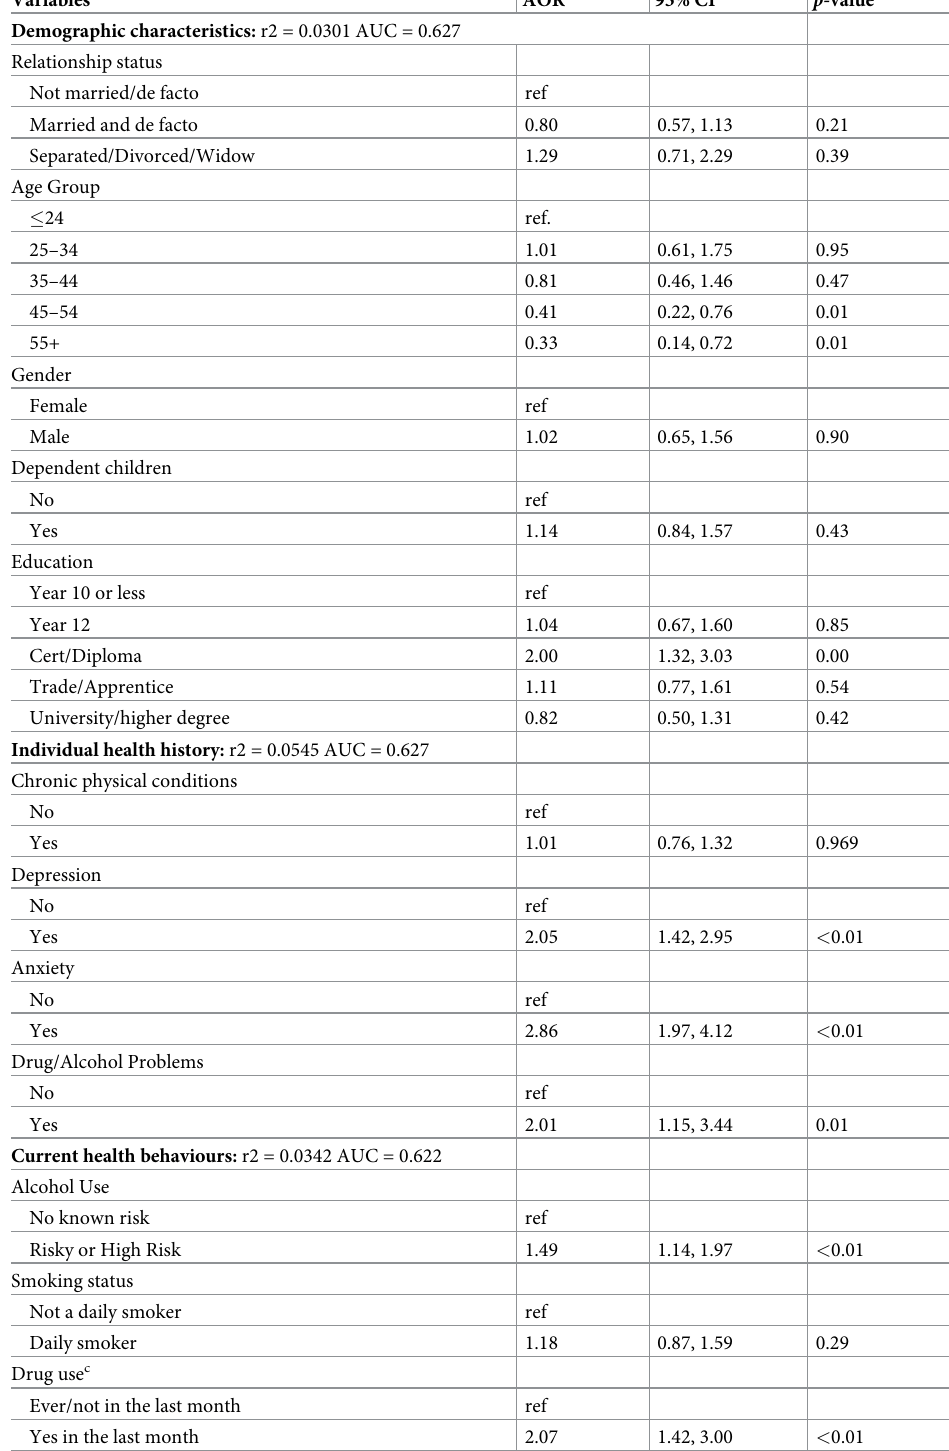
Table 4. Results of multivariable logistic regression models of reporting high and very high psychological distress on demographic characteristics, individual health history and current health behaviours (n =